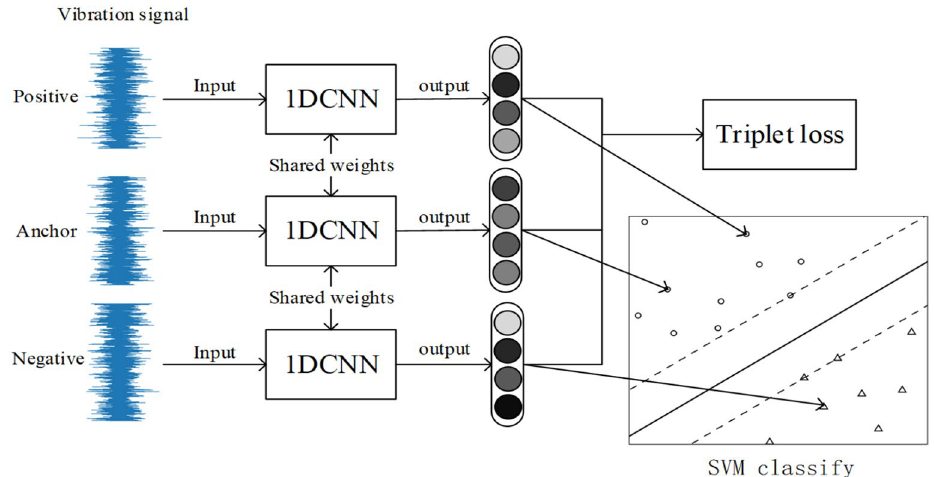
Figure 7. Training flow of triplet network and SVM.